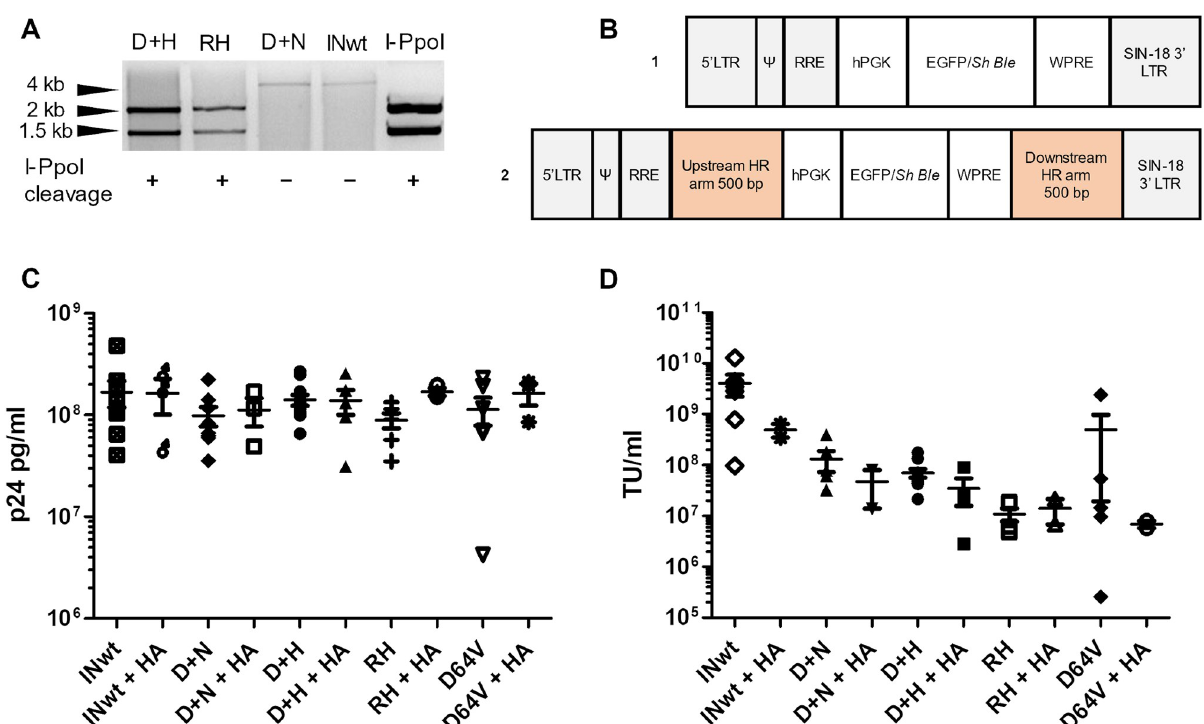
Fig 1. Characterisation of the lentivirus vectors (LVs) used in this study. A . IN-I-PpoI fusion protein endonuclease activity of the D+H, RH and D +N LVs in vitro . A representative image of cleavage of a plasmid containing an I-PpoI recognition site is shown. INwt and I-PpoI enzyme were included as controls. Expected fragment sizes after Bsu1I linearization and I-PpoI cleavage are 1938 + 1403 bp. B . Transgene constructs used in this study: 1 . The standard 3 rd generation LV transgene construct; 2 . The 3 rd generation LV transgene construct containing rDNA-compatible homology arms (HA LVs). C . Particle titres of the LVs used in this study, measured by p24 capsid-protein based ELISA. The mean ± SEM are shown for each LV. D . The functional titres of the LVs as measured by flow cytometry from cells transduced with EGFP-LVs. The mean ± SEM are shown for each LV.